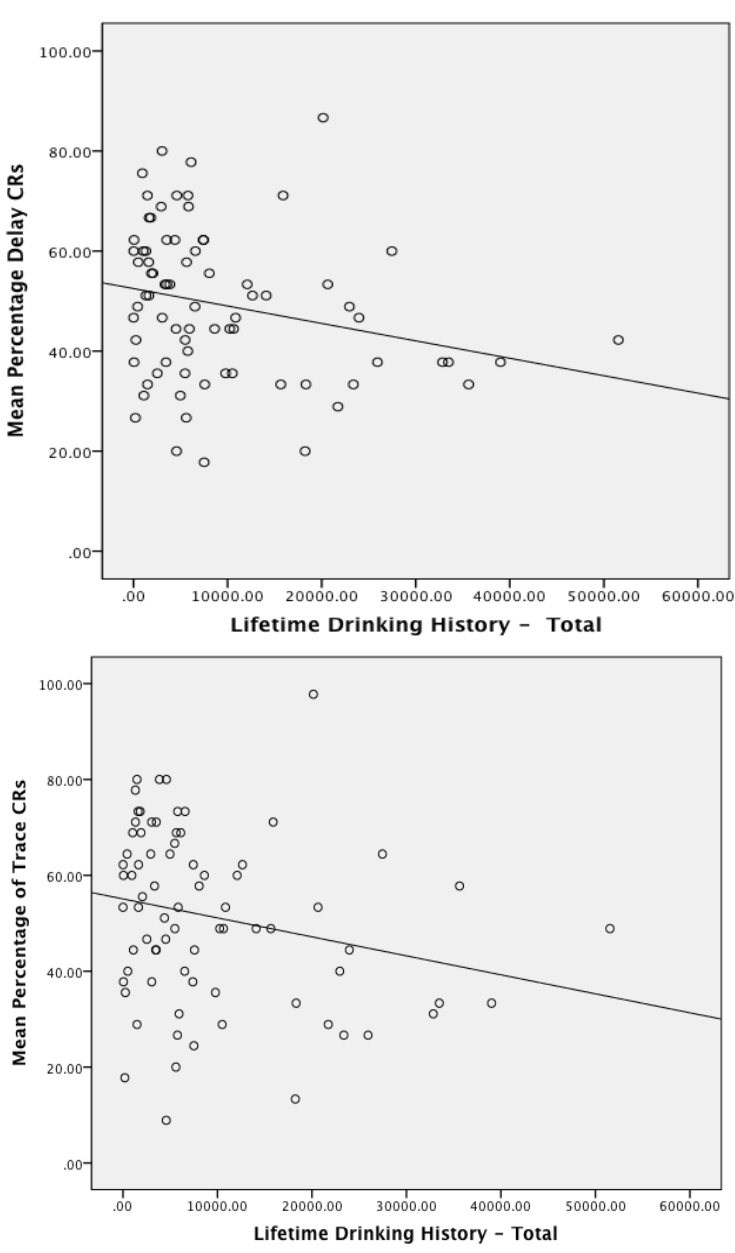
Figure 5. Scatterplots of the mean percentage of conditoned reponses for Delay ( a ) and Trace ( b ) as a function of lifetime history of alcohol use (total quantitiy